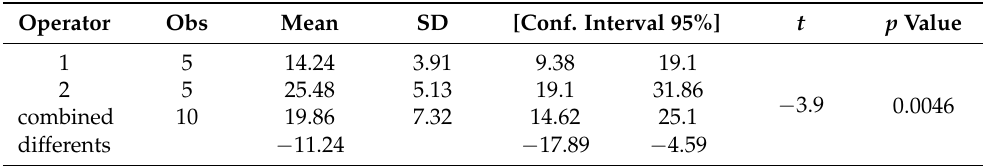
Table 4. Double-tailed t -test verifying a significant difference between the two operators in terms of implant placement